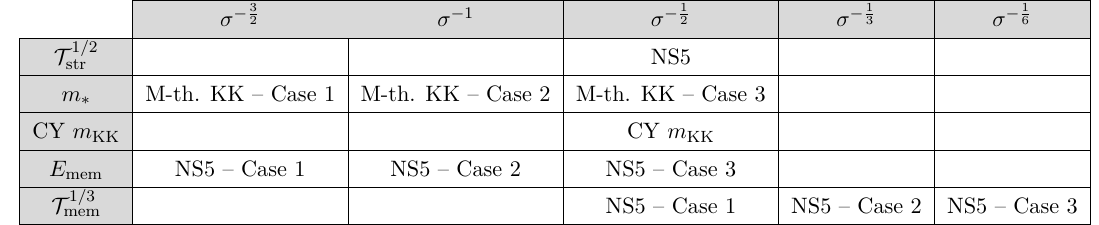
Table 3 . Mass scalings along the flows generated by NS5-strings in heterotic